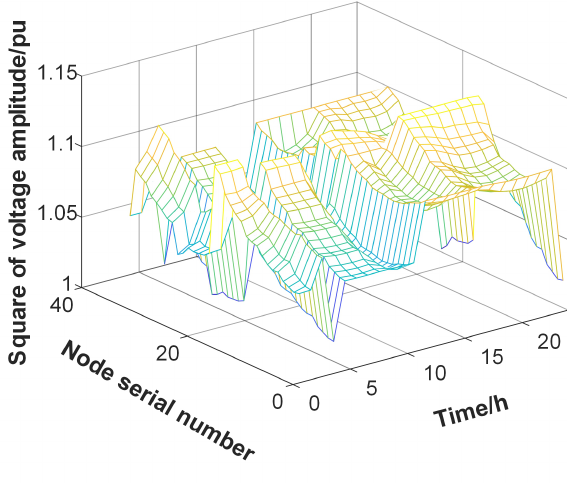
Fig. 12. Square of voltage amplitude of each node